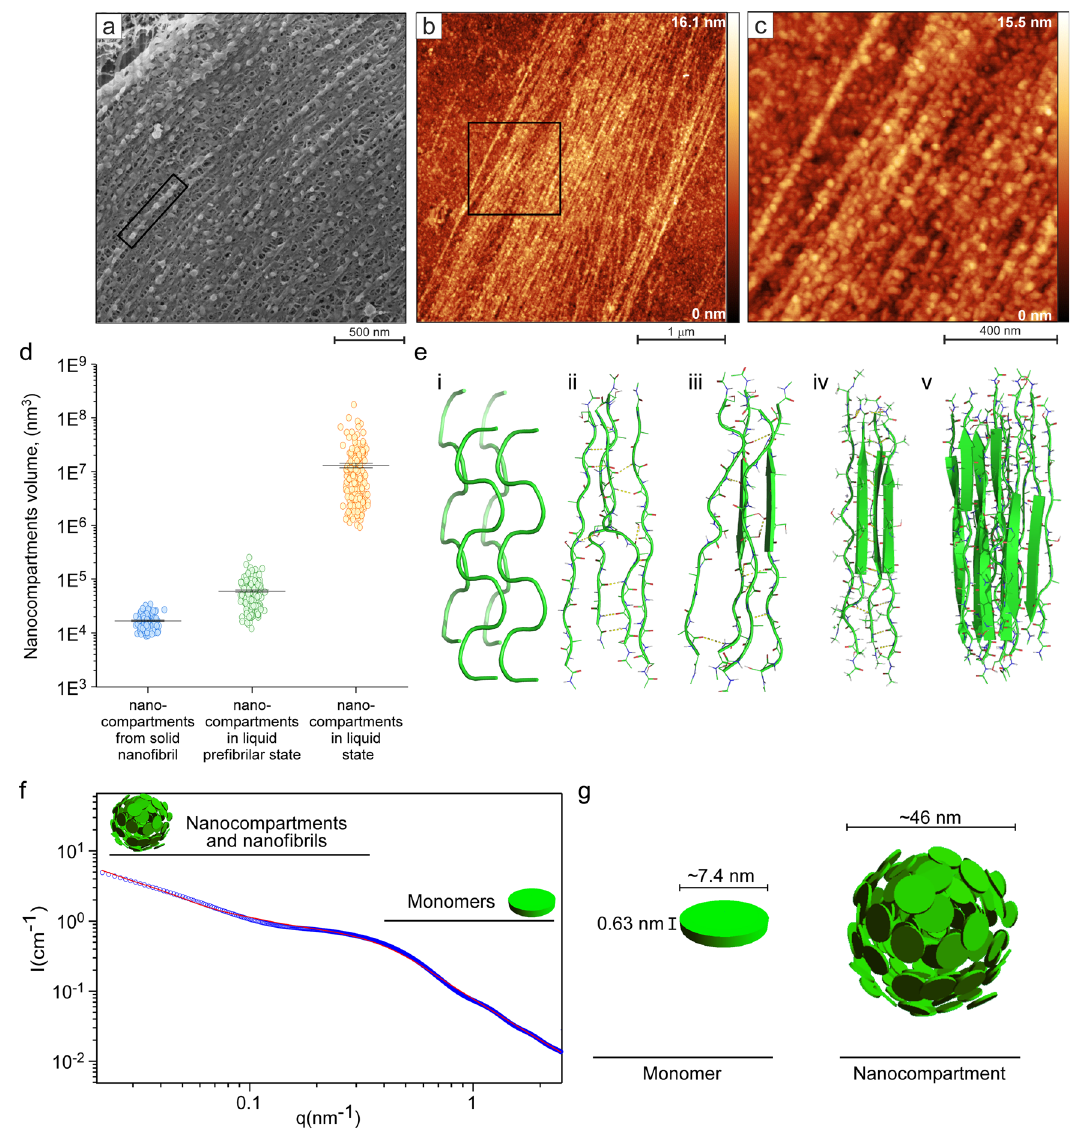
Fig. 4 | The mechanism underlying the silk protein structural transitions. a Freeze-fractured cryo-electron microscopy image of the anterior part of the silkworm silk gland revealing an event of linear ordering of the fi broin nano- compartments (denoted by a black rectangle). b AFM image of silk fi broin protein self - assembledintonanoscale fi brils. c Enlargedimageof( b )revealingthepresence of spherical assemblies in nano fi brillar structures. d Volumetric calculation of unorderedsilk fi broinnanocompartmentsnotsubjectedtoelongational fl owstress (average volume of 1.2*10 7 nm 3 ) vs. nanocompartments that have aligned due to shear produced by elongational fl ow stress (average of 60,160 nm 3 ) vs. nano- compartments subjected to shear stress (average volume of 16,750nm 3 ). The standard error and the mean are indicated in the graph. e Molecular dynamics simulations of silk fi broin conformational transitions from a relaxed state